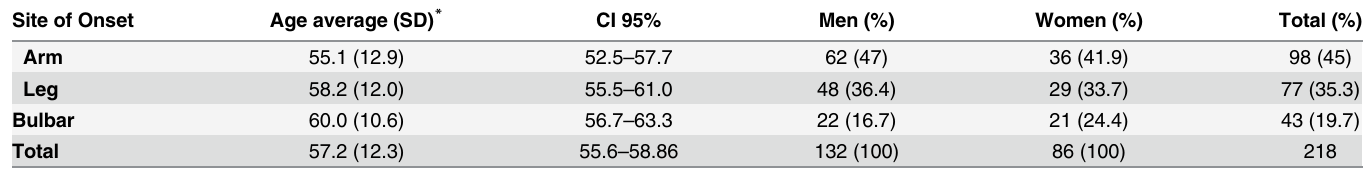
Table 1. Amyotrophic Lateral Sclerosis patients profile considering the site of onset, age and